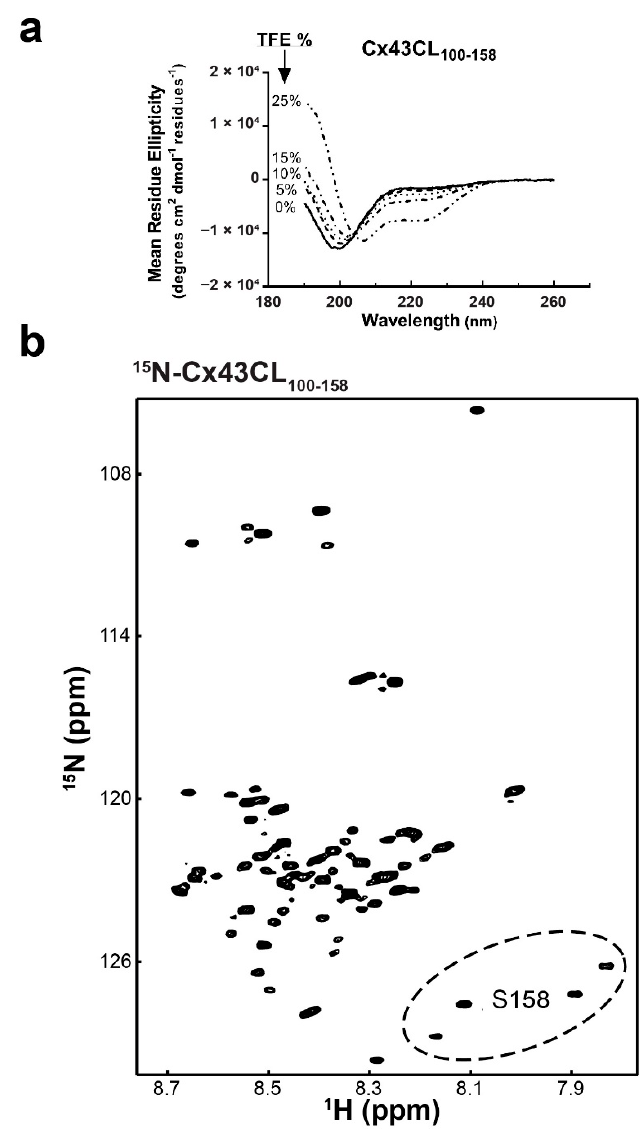
Figure 3. Structural analysis of the Cx43CL 100-158 domain. ( a ) CD spectra of Cx43CL 100-158 in the presence of increasing amount of TFE (percentages indicated on the left side of the curves). ( b ) × PBS (pH 5.8, 7 ◦ C). Example of the CT region 15 N-HSQC spectrum of 15 N-labeled Cx43CL 100-158 in 1 sampling multiple confirmations is shown with residue S158 peaks (circled